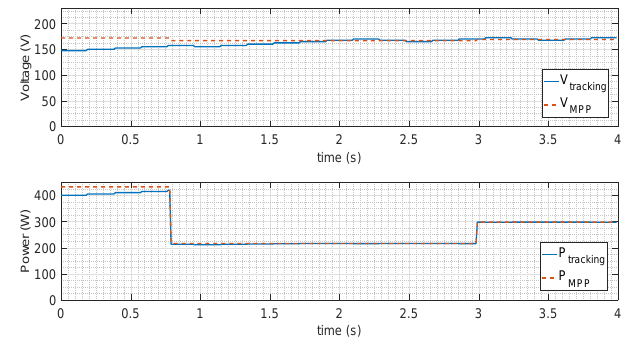
Figure 25. Tracking profile of P & O under sudden irradiance changes.